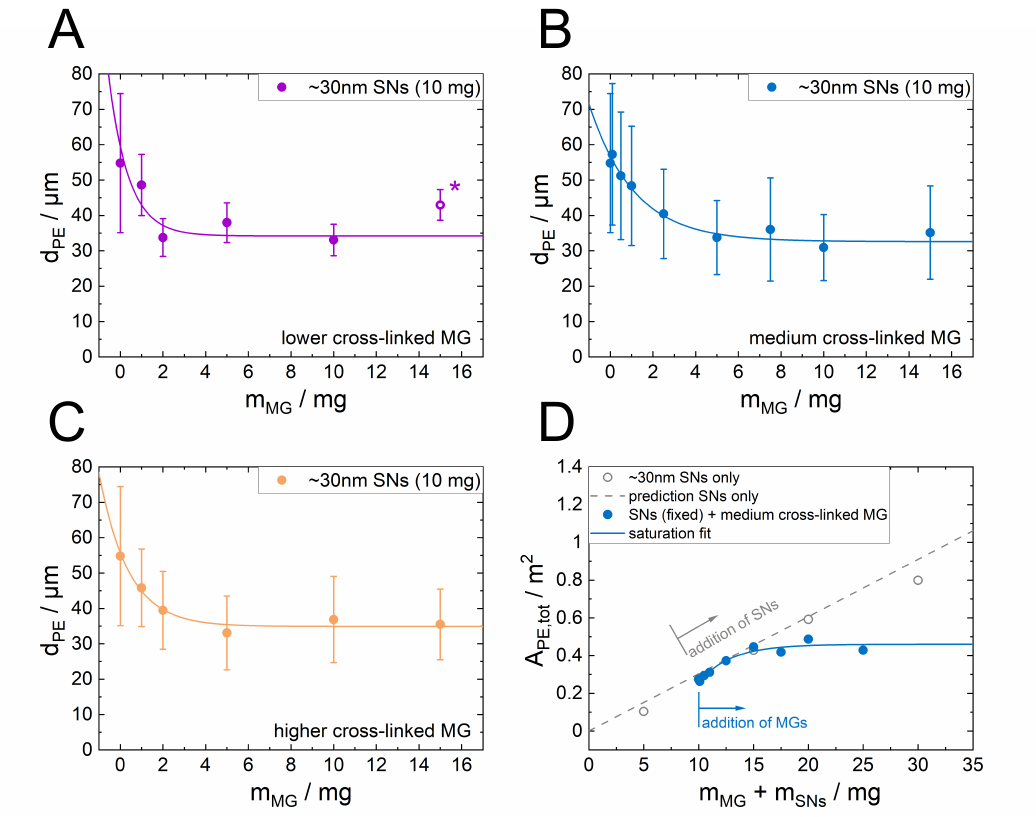
Figure 3. ( A – C ) Sauter mean diameter for emulsions ( V PE,tot = 12.55 mL, 20 vol%, oil type 1-dodecene) formed with a constant amount of SNs (10 mg) as a function of the MG content using MGs with a lower ( A ), medium ( B ) or higher ( C ) cross-linker content. The data are well described by Equation (2) (average deviation less than 9% for all fits). The emulsion formation with the highest amount of present MG with the lowest cross-linker content lead to the formation of a double emulsion with oil droplets inside the water phase. The data point marked with (*) was produced, evaluating only the outer droplet diameter while ignoring the inner droplets. The error bars represent the standard deviation of the droplet size distribution. ( D ) Total emulsion droplet area A PE,tot for the emulsions prepared with the ∼ 30 nm SNs only and with the addition of the medium cross-linked MG over the total stabilizer mass calculated with Equation